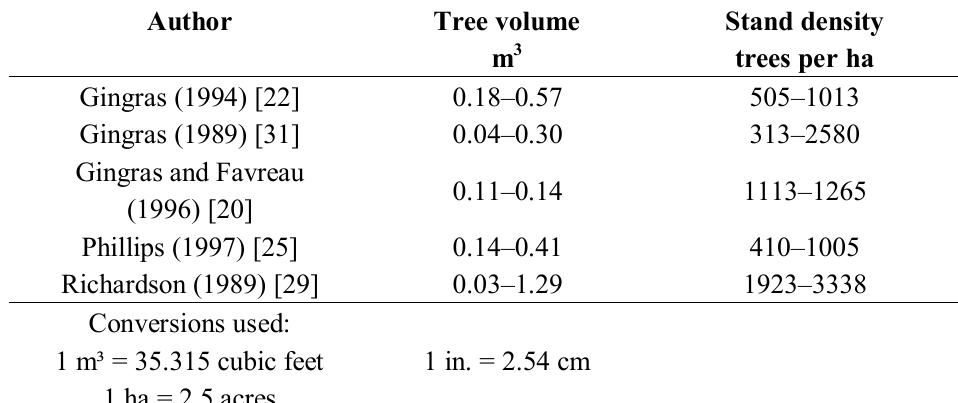
Table 5. Summary of tree volume and stand density of timber harvesting studies.